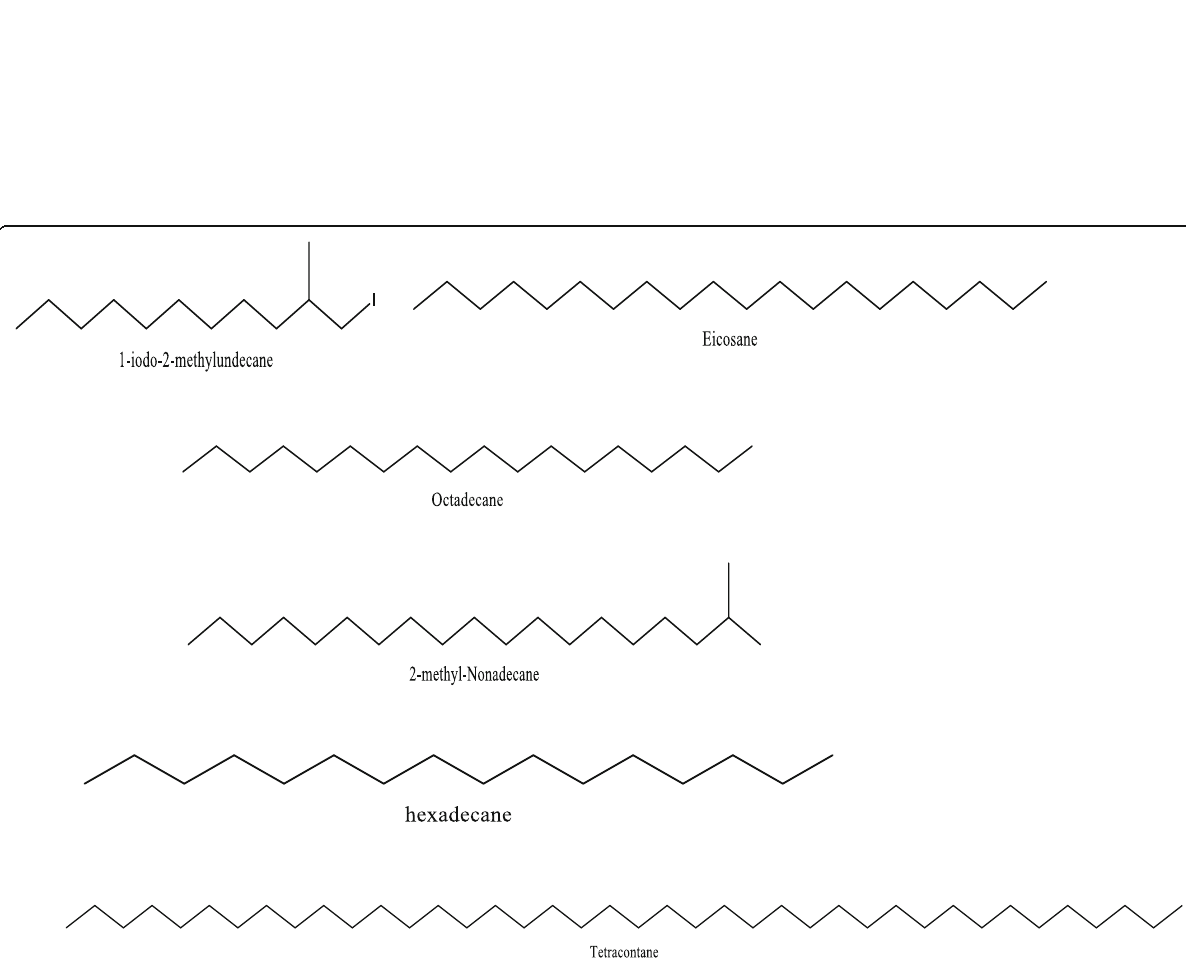
Fig. 18 Chemical structures of some alkanes isolated from A. vera and A.